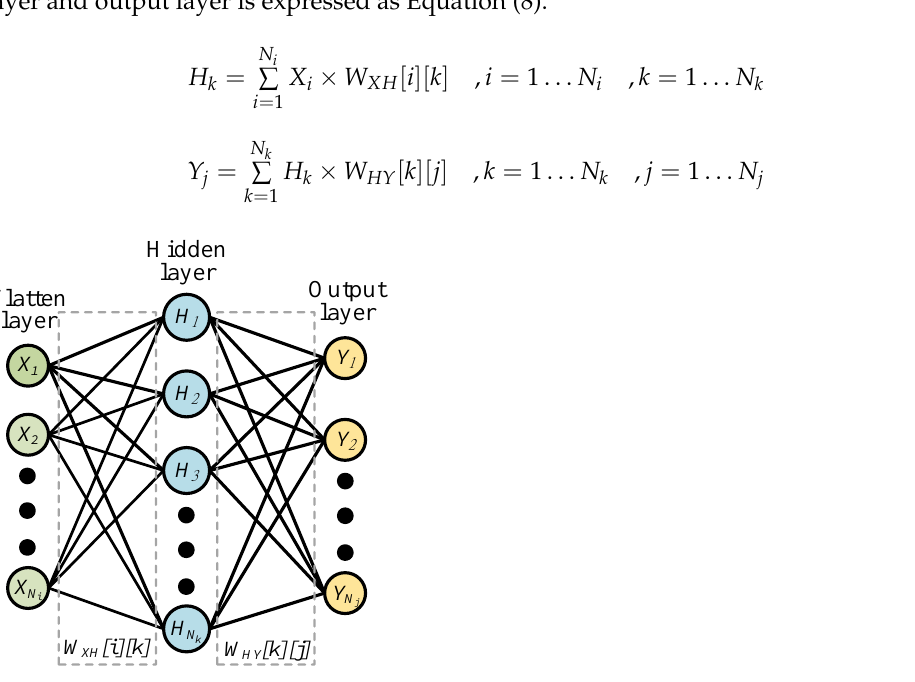
Figure 10. The structure of a fully connected layer.